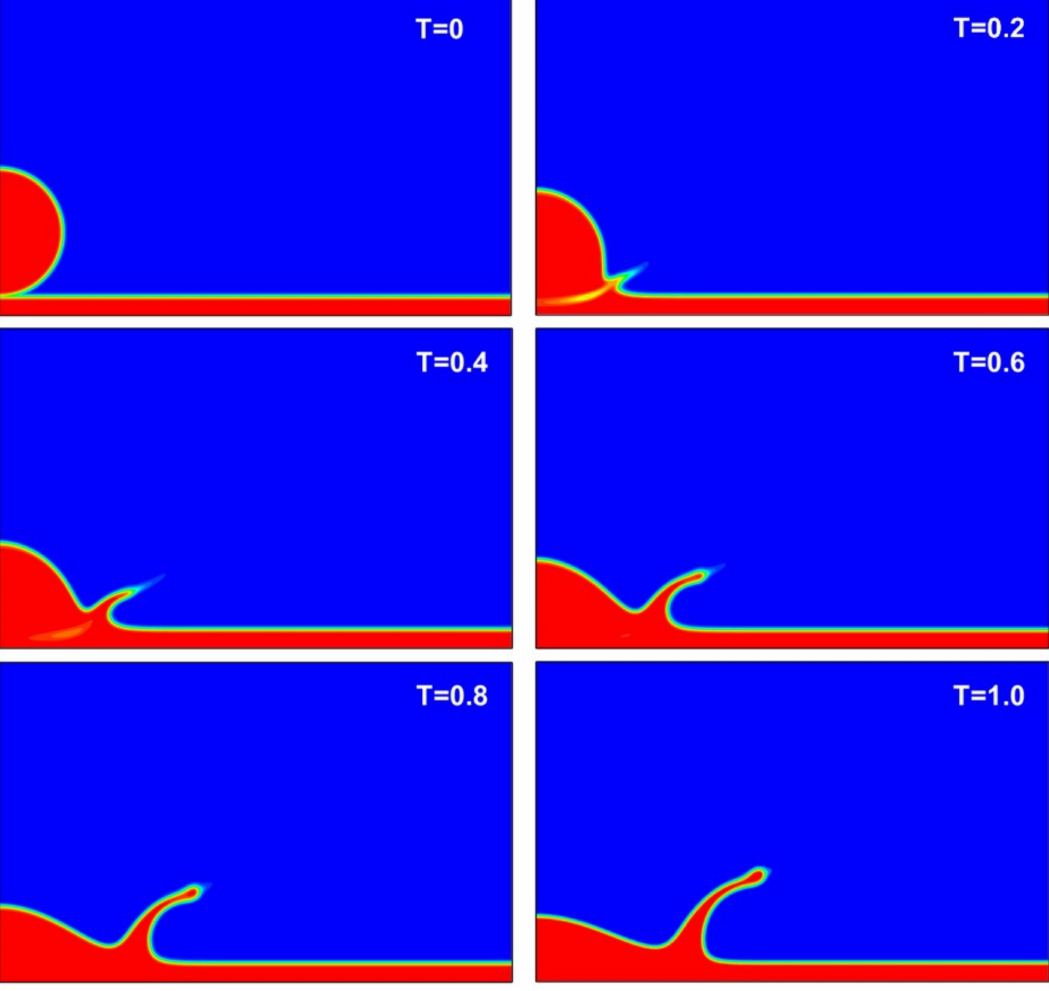
Figure 20. Development of the interface at Re = 800 and We = 150 with the present